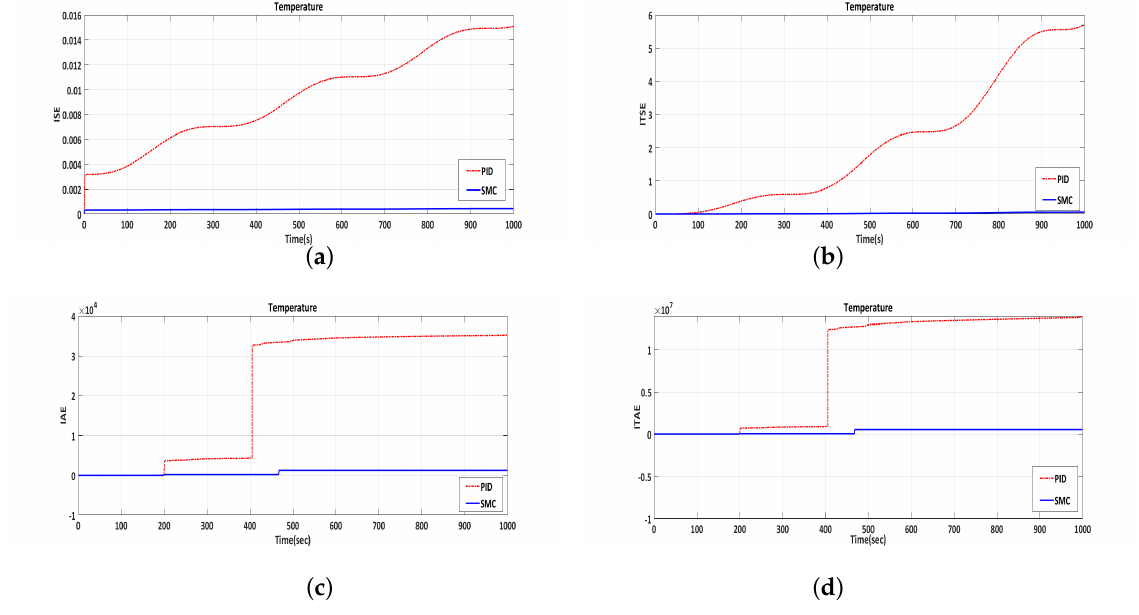
Figure A3. Performance indices ( a ) ISE, ( b ) ITSE, ( c ) IAE, ( d ) ITAE graph of controllers for temperature output of the second reference signal, ramp with